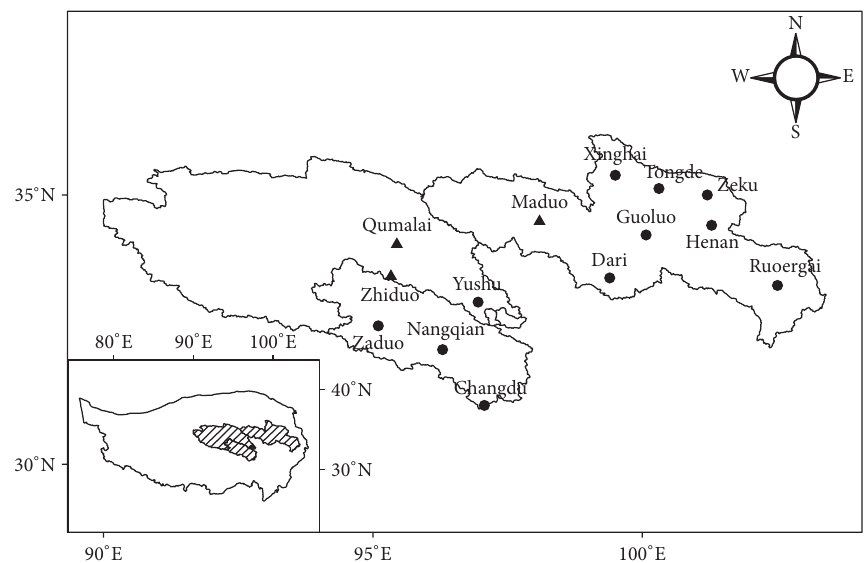
Figure 1: Study area and locations of the meteorological stations in the Three Rivers Source Region (TRSR) of the Tibetan Plateau (TP). Black circles reflect data availability from 1960 to 2014, and black triangles reflect data availability from 1985 to 2014.